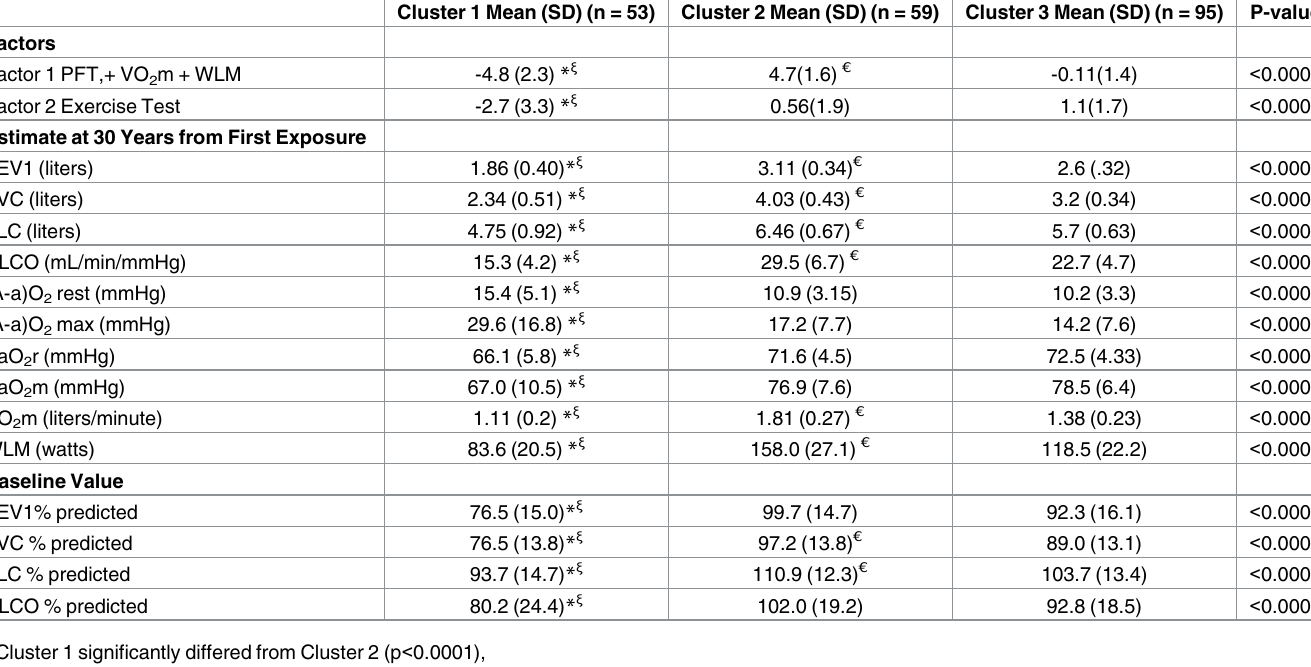
Table 5. Association between lung function and